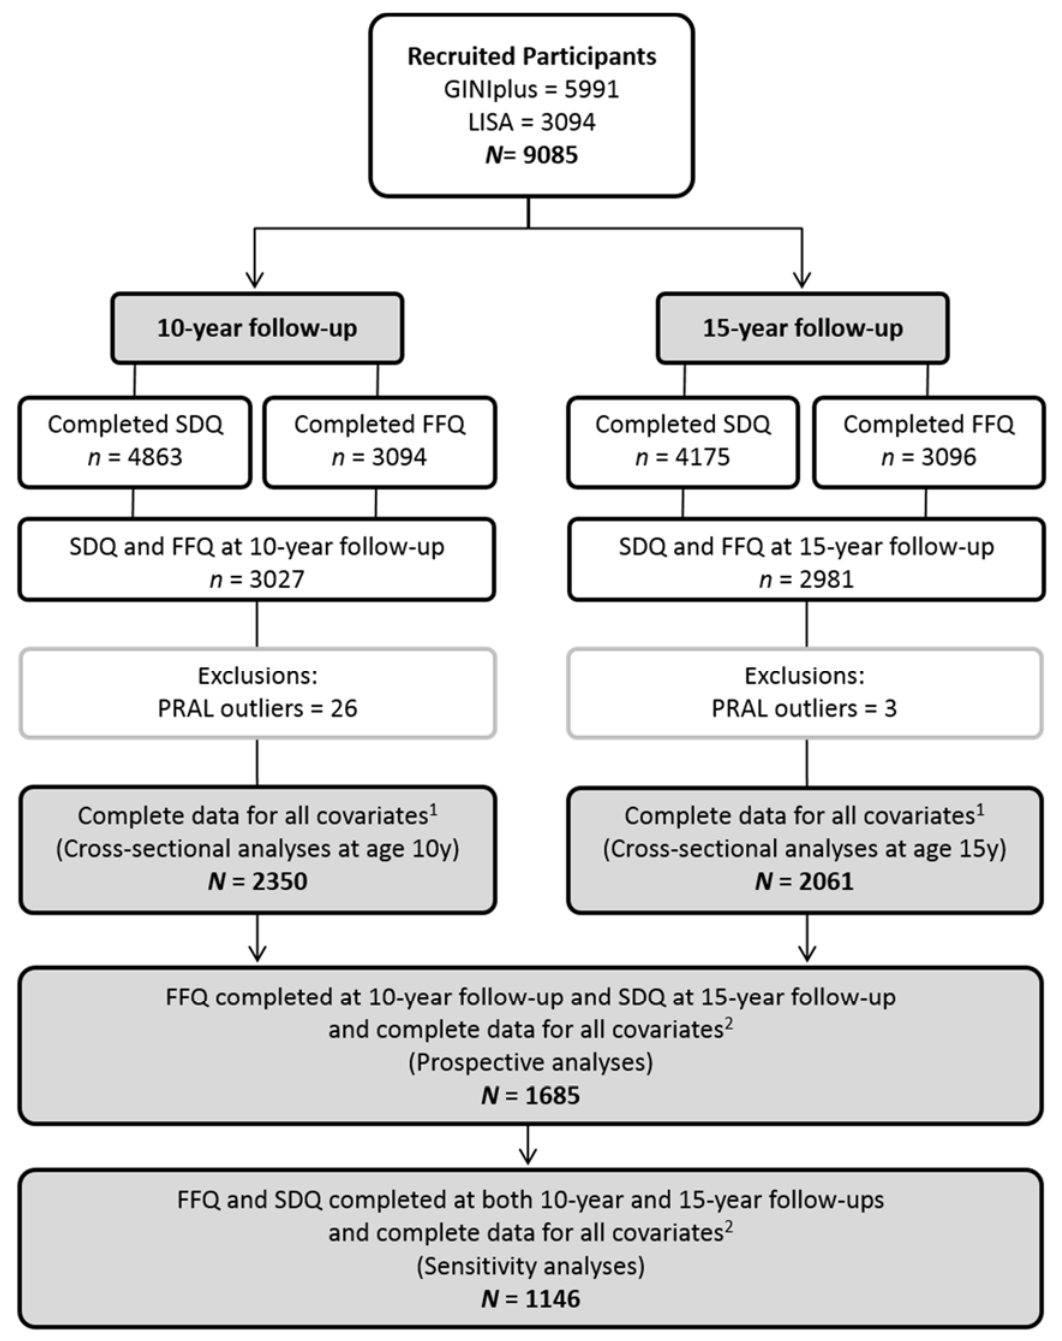
Figure 1. Flowchart study population. Potential renal acid load (PRAL) outliers, at age 10 years: females with values outside the range − 28 to 46, and males outside − 34 to 53; at age 15 years: females with values outside the range − 38 to 73, and males outside − 40 and 106; 1 Covariates: total energy intake, body mass index, moderate–vigorous activity, screen time, pubertal status, parenteral education, study (arm), region, sex; 2 Additional covariate: Strengths and Difficulties Questionnaire (SDQ) at age 10 years.